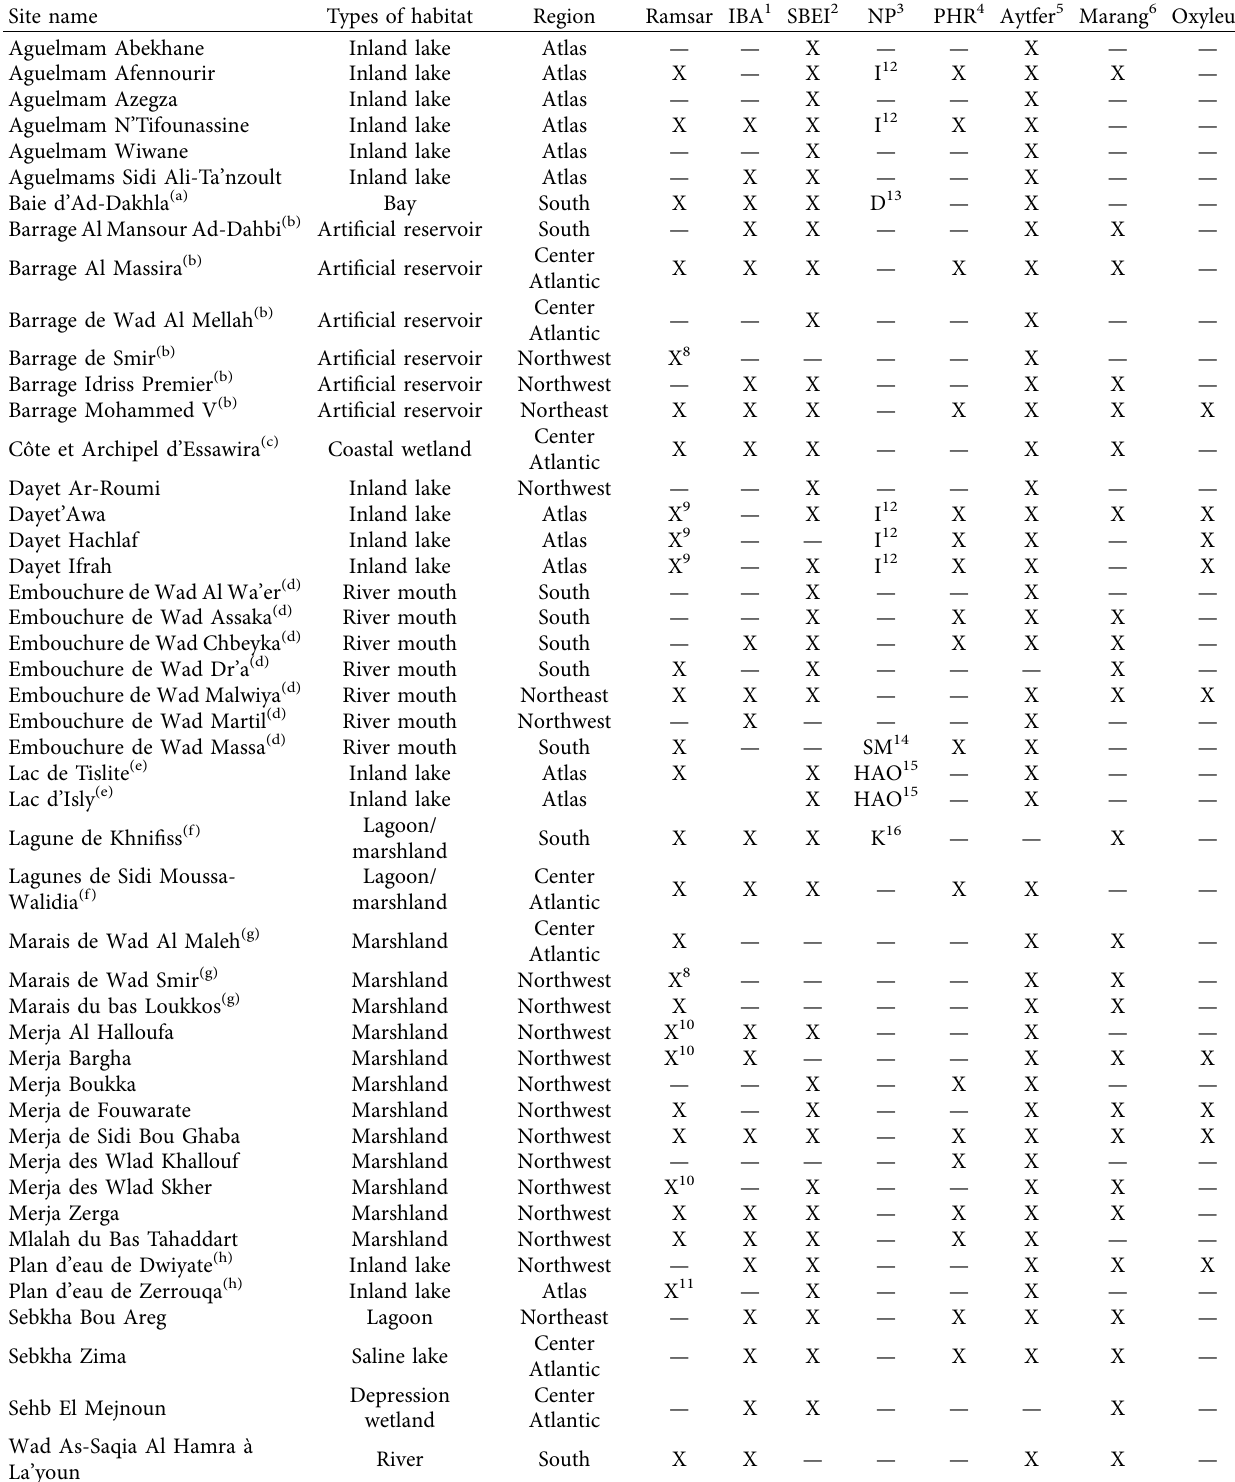
Table 5: Conservation statuses of the three species’ hosting